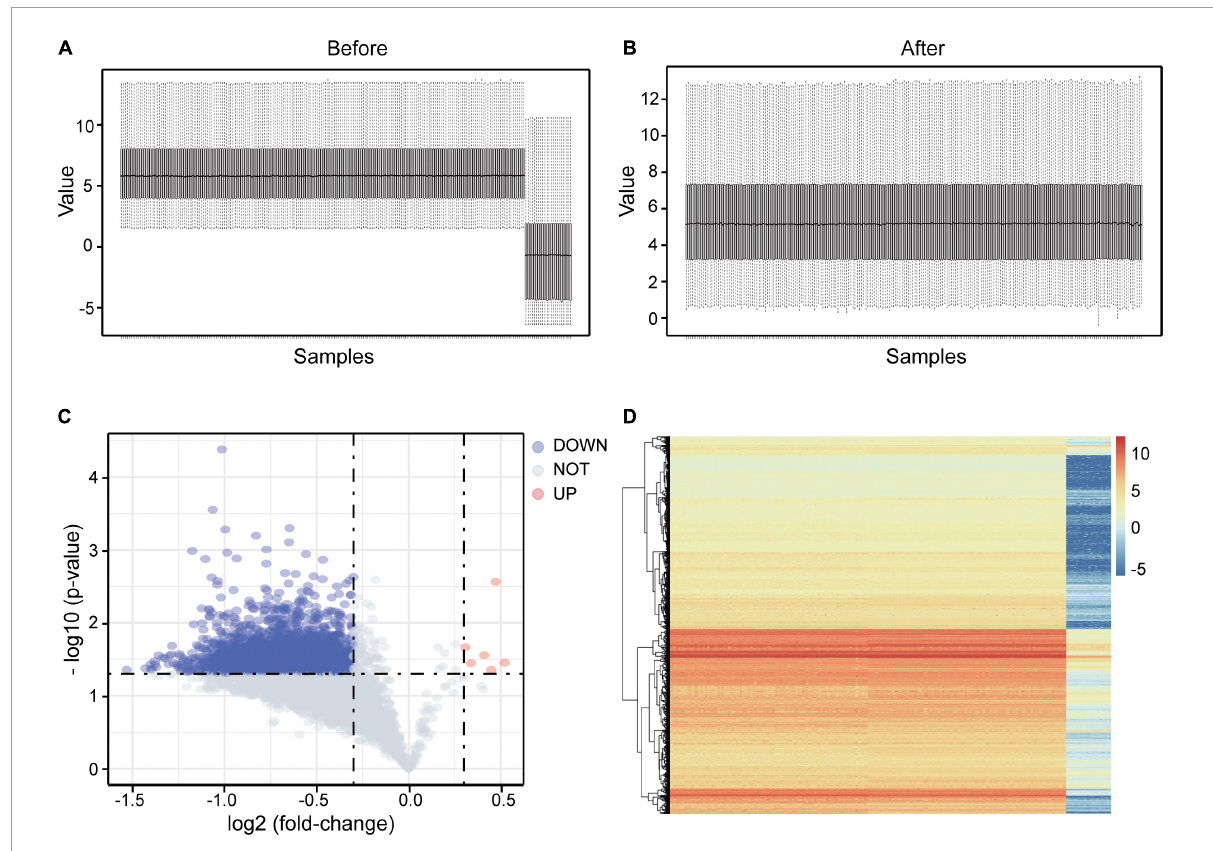
FIGURE2 DEGs screening in integrated microarray of GSE98793 and GSE76826. (A) The boxplot showed an obvious batch effect before the data merged. (B) The boxplot showed the pleasant effect of data cleaning. (C) Volcano plot of the integrated exprSet. Data points in red represent up-regulated, and blue represent down-regulated genes. (D) Heatmap of DEGs identified in integrated microarray. Legend on the top right indicates the change of the